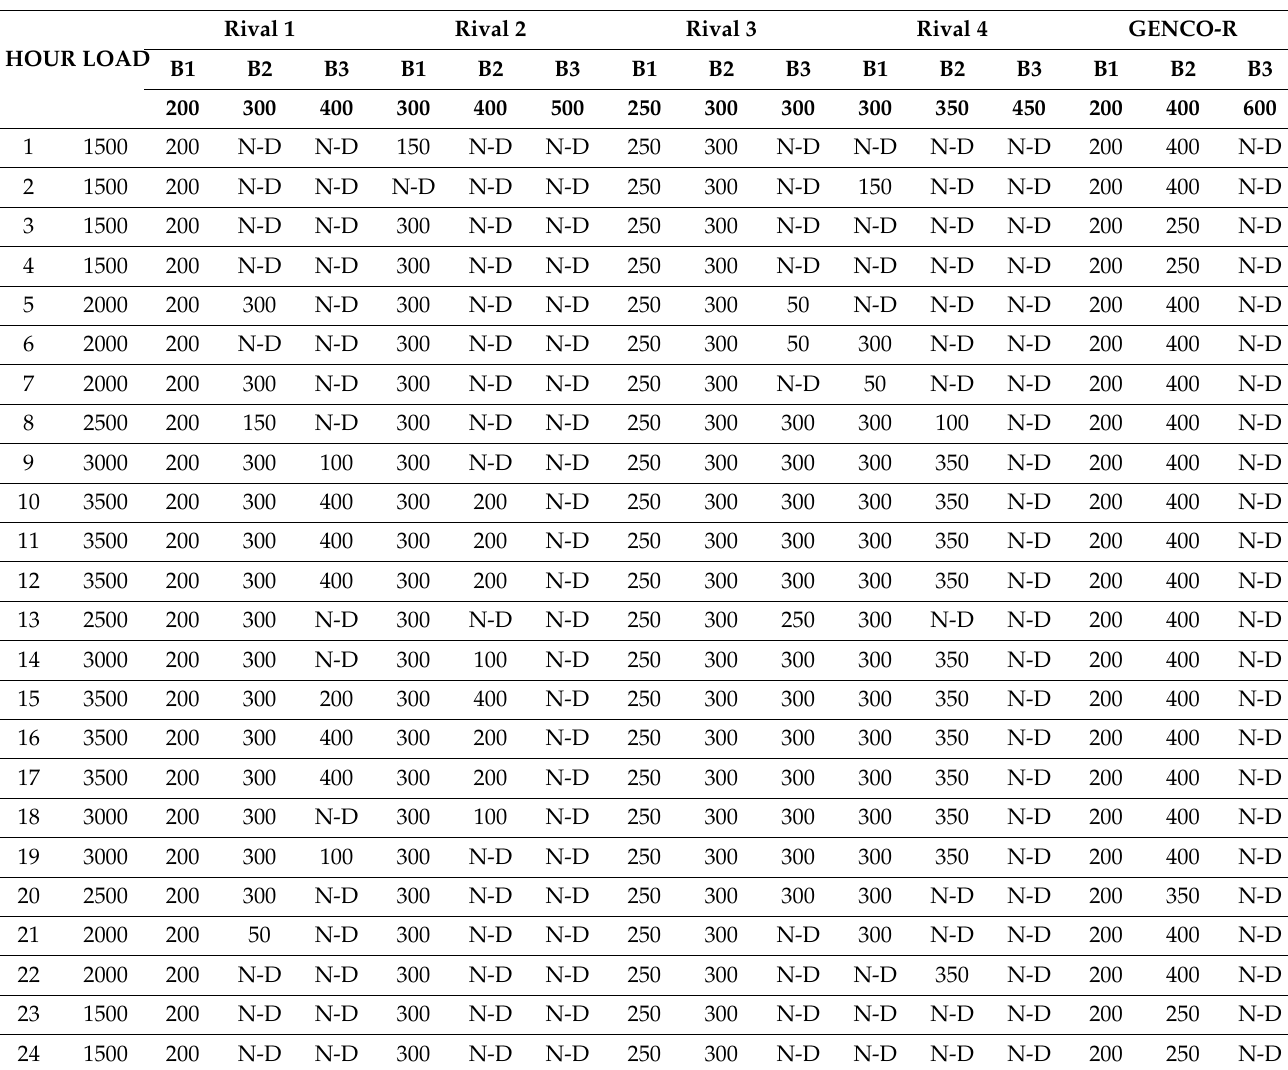
Table 11. Dispatch Obtained by Different Algorithms by using Gamma PDF for